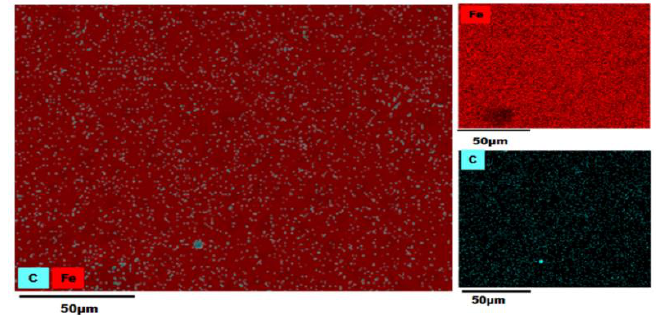
Figure 12. Energy-Dispersive X-Ray Spectroscopy (EDS) map of a 90° elbow exit surface before the test.